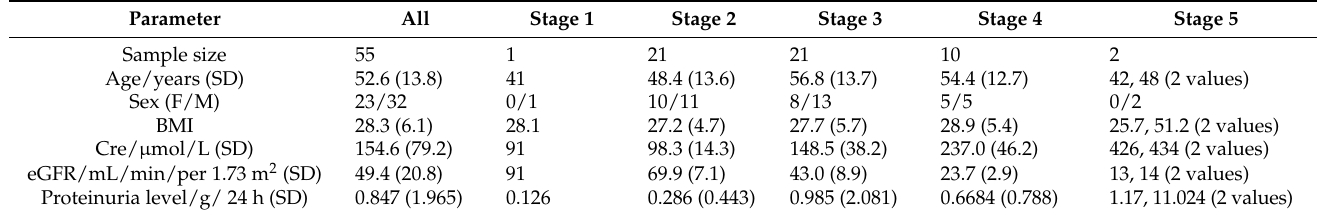
Table 1. Characteristics of patients enrolled in the study by stage, mean values with standard deviation (SD).